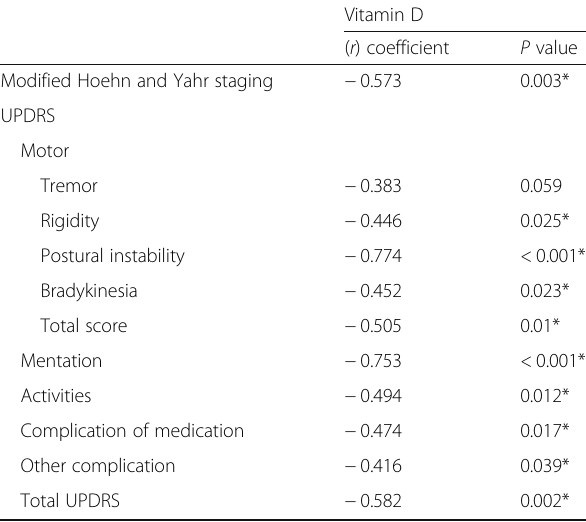
Table 5 Correlation between Modified Hoehn and Yahr staging and UPDRS and serum vitamin D